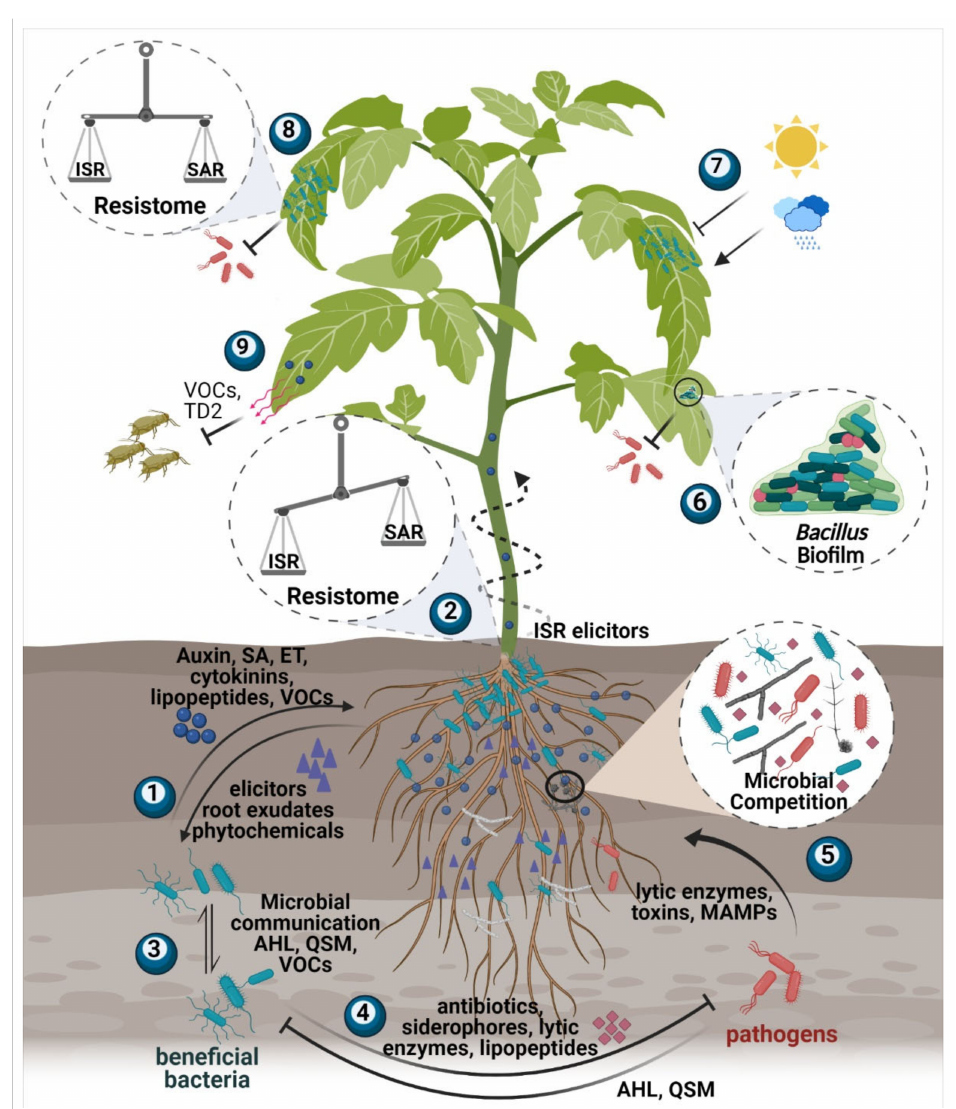
Figure 2. A schematic representation of the multifaceted interactions among BCAs, host plants, pathogens, and plant microbiota. Following rhizosphere application, BCAs and other beneficial bacteria perceive host signals and are recruited by the plant host ( 1 ). BCAs colonize roots and provide metabolites to plant roots that support growth and activate signaling pathways that trigger the Induced Systemic Resistance (ISR) and suppress Systemic Acquired Resistance (SAR) signaling ( 2 ). In parallel, BCAs interact with rhizosphere microbiota. This involves inter- or intra-specific communication by secretion of quorum sensing molecules ( 3 ) or antagonism with commensal bacteria and plant pathogens. Antagonism involves antibiosis by the production of bactericidal metabolites ( 4 ) and competition for nutrients and space ( 5 ). BCA colonization of the plant is largely dependent on its ability to form biofilm on roots but especially on leaves and crops in which the epidermis is a nutrient-limited hostile environment ( 6 ). Colonization of aerial parts largely depends on environmental conditions ( 7 ), humidity being the dominant factor. Following leaf colonization, microbial elicitors are perceived by plant receptors and trigger synergistically ISR and SAR ( 8 ) but also defense responses to insect pests by the production of volatile compounds of insecticidal enzymes ( 9 ). SA, Salicylic Acis; ET, Ethylene; VOCs, Volatile Organic Compounds; AHLs, N-Acyl homoserine lactone; QSM, Quorum Sensing Molecules; MAMPs; Microbe-Associated Molecular Patterns; ISR, Induced Systemic resistance; SAR, Systemic Acquired Resistance; TD2, Threonine dehydratase 2 biosynthetic protein. This illustration was created using the BioRender online software (https://biorender.com/ accessed on 21 January